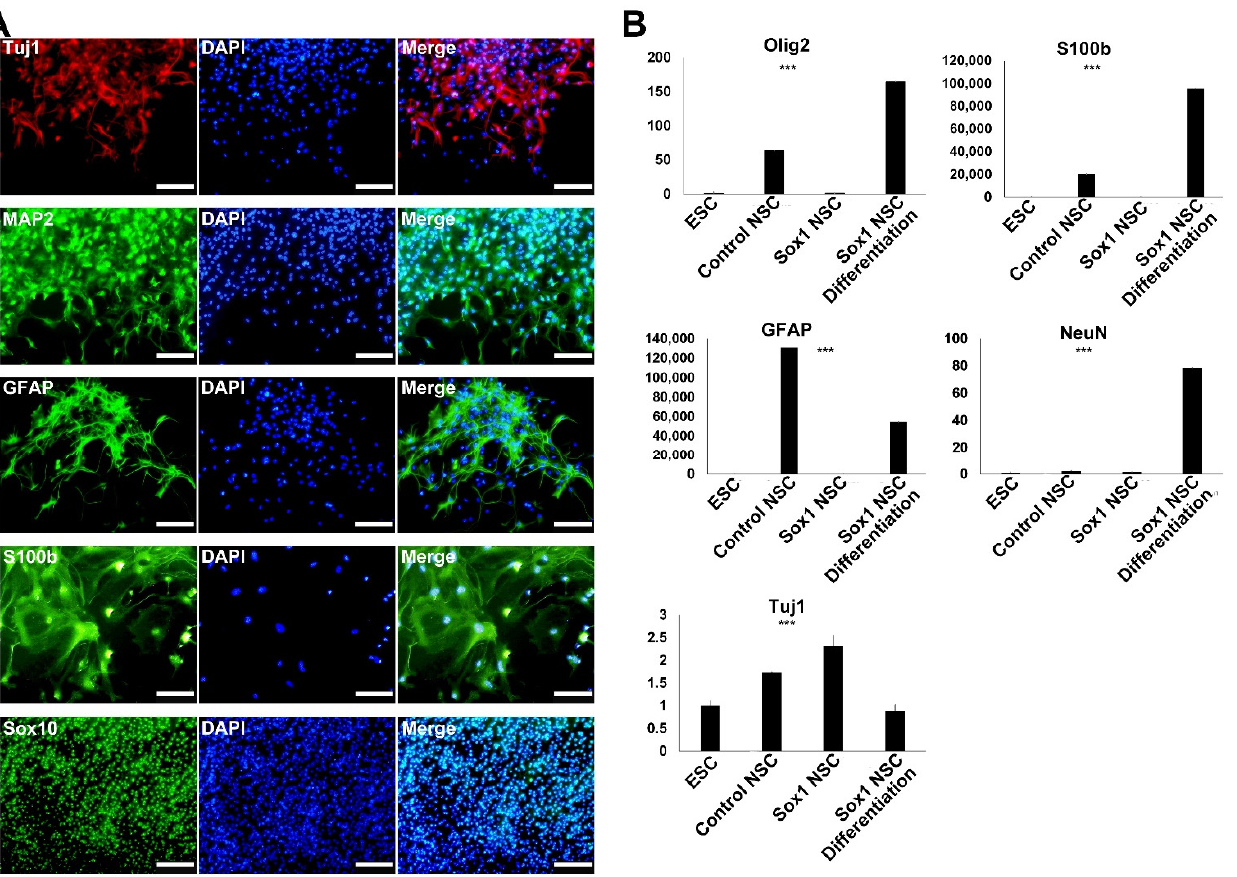
Figure 5. Differentiation potential of the established NSCs. ( A ) Immunofluorescence analysis of cells differentiated from NSCs using neural subtype markers, including neurons (Tuj1 and MAP2), astrocytes (GFAP and S100b), and oligodendrocytes (Sox10 + ). ( B ) Real-time RT-PCR analysis confirmed the differentiation potential of established NSCs into neuronal cells ( Tuj1 and NeuN ), astrocytes ( GFAP and S100b ), and oligodendrocytes ( Olig2 ). One-way ANOVA: *** p < 0.001 ( n = 3).